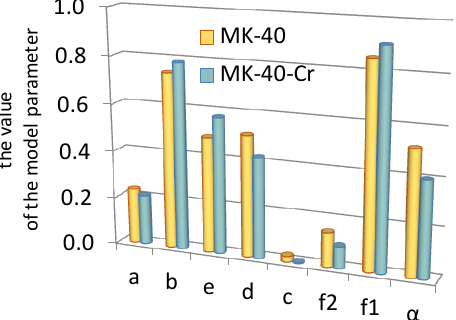
Figure 7. Model parameters characterizing the paths of current transfer (a, b, c, d, e), volume fraction of the gel (f 1 ) and intergel (f 2 ) phases of the MK-40 membrane and orientation of the phases in the direction of the current flow ( α ). 1, unmodified MK-40 sample; 2, MK-40-Cr membrane containing